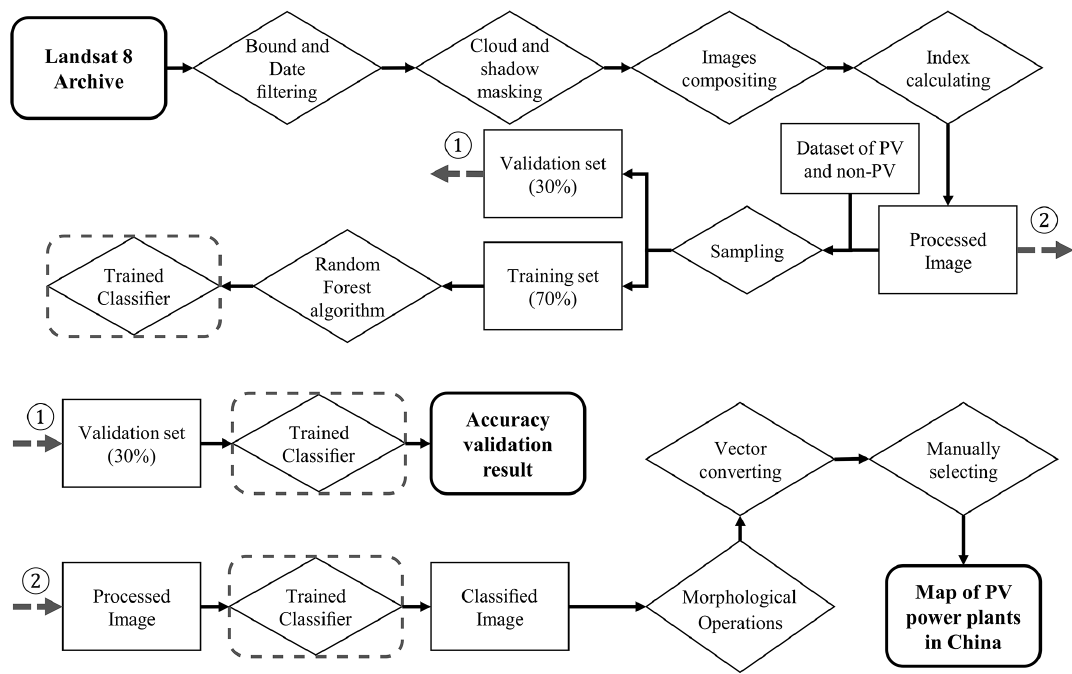
Figure 3. The flowchart of mapping the PV power plant in